Question: How would you classify this visualization?
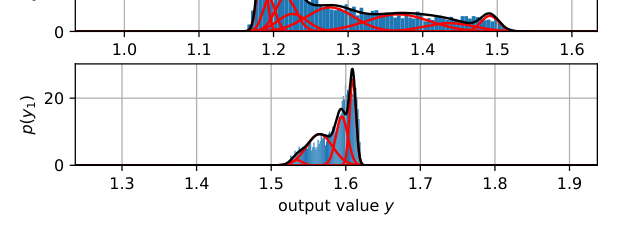
Answer: histogram